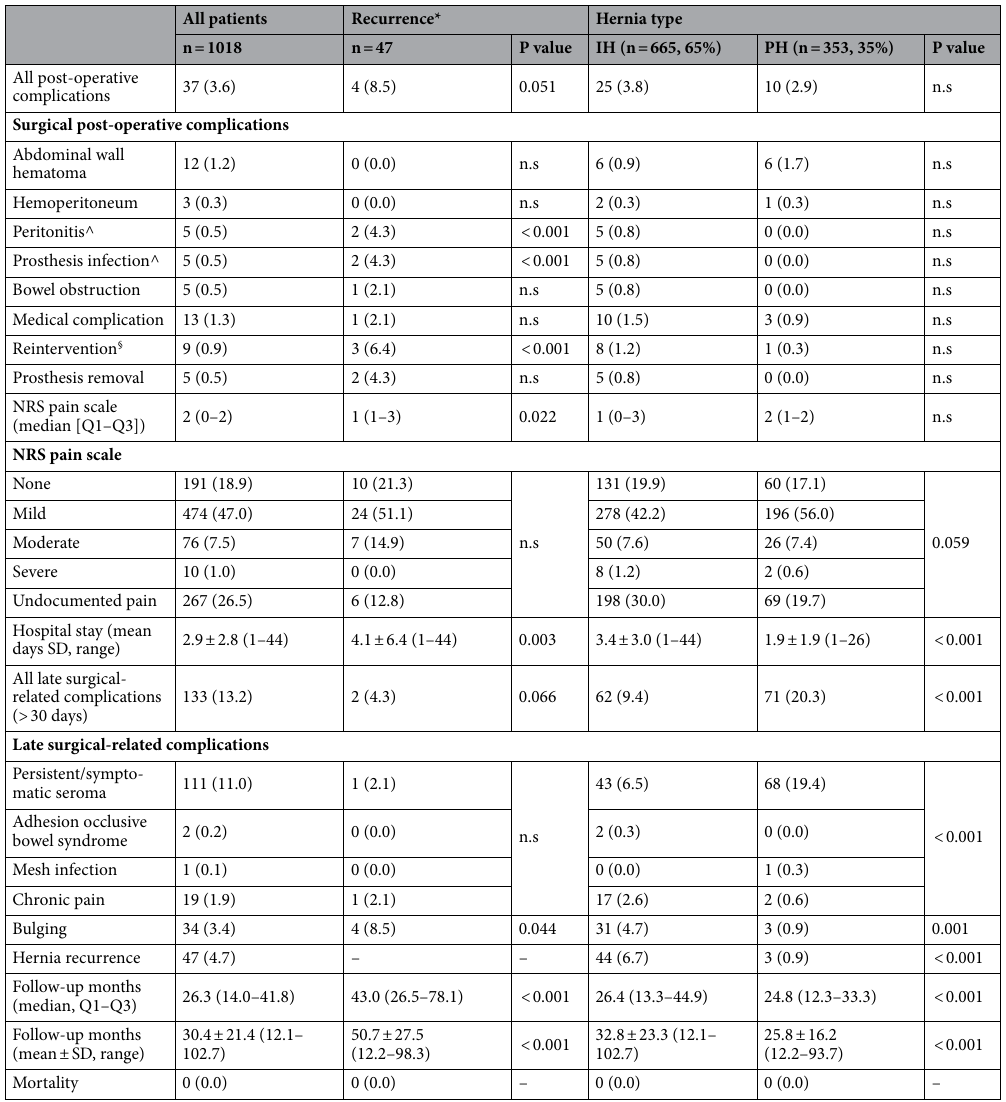
Table 3. Early post-operative and late outcomes for all patients (n = 1018), recurrences* (n = 47) with significative risk factors (p value), and comparison between IH (n = 665) and PH (n = 353). Data presented were n (%), unless specified. Q1 ; first quartile, Q3 ; third quartiles; n.s. , not significative. *Comparison with all patients without recurrence (n = 971). °6 patients presented more than one complication. ^All patients with peritonitis presented infection of the mesh. § Reinterventions were managed laparoscopically in 2 cases and with open approach in 7